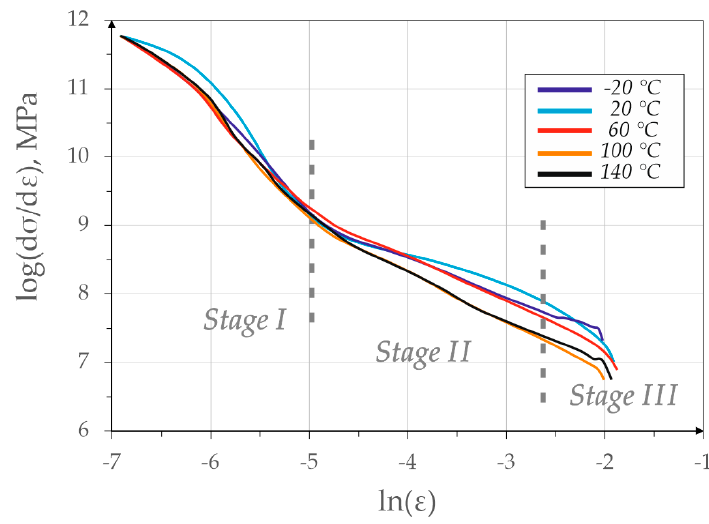
Figure 10. Jaoul–Crussard analysis of the strengthening stages for the samples deformed at di ff erent